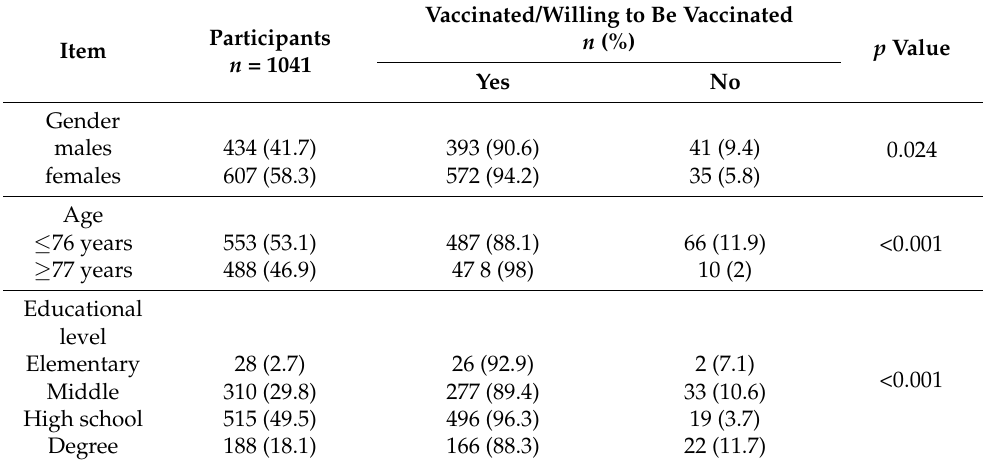
Table 2. Socio-demographic characteristics of participants on the whole and grouped by willing- ness/unwillingness to be